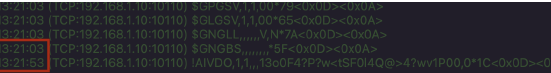
Figure 11. DoS attack in OpenCPN debug window.